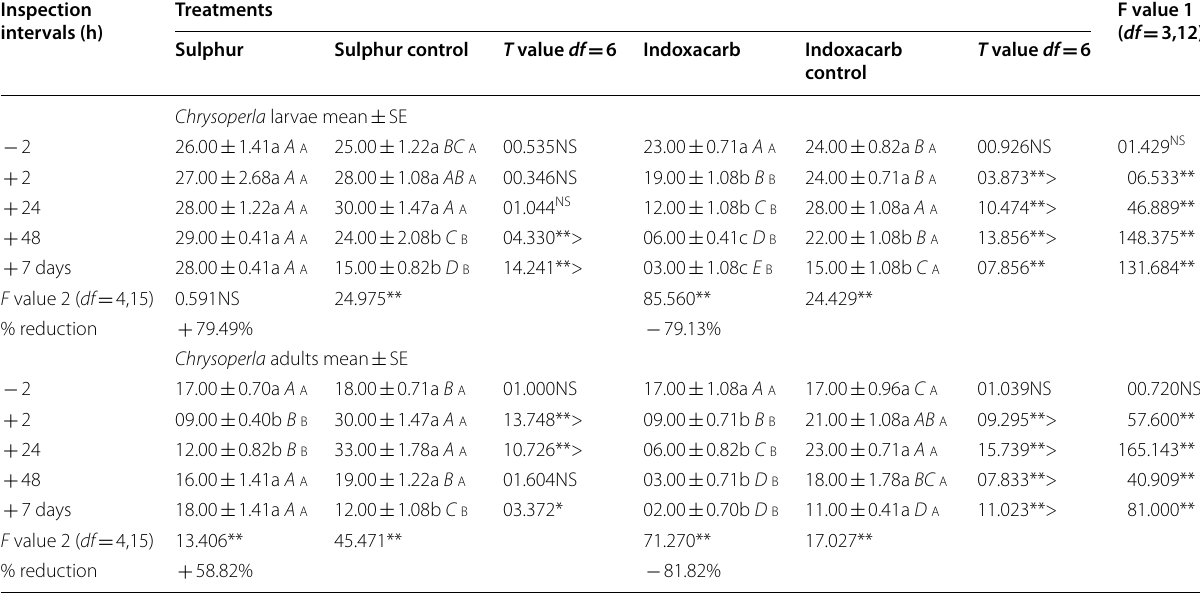
** highly significant,* significant, NS, nonsignificant In horizontal rows, means followed with different small letters are statistically different ( P > 0.5) ( F value 1) In horizontal rows, per each treatment, means followed with different small capital letters are statistically different ( P > 0.5) ( T value) In vertical columns, means followed with different capital Italic letters are statistically different ( P > 0.5) ( F value